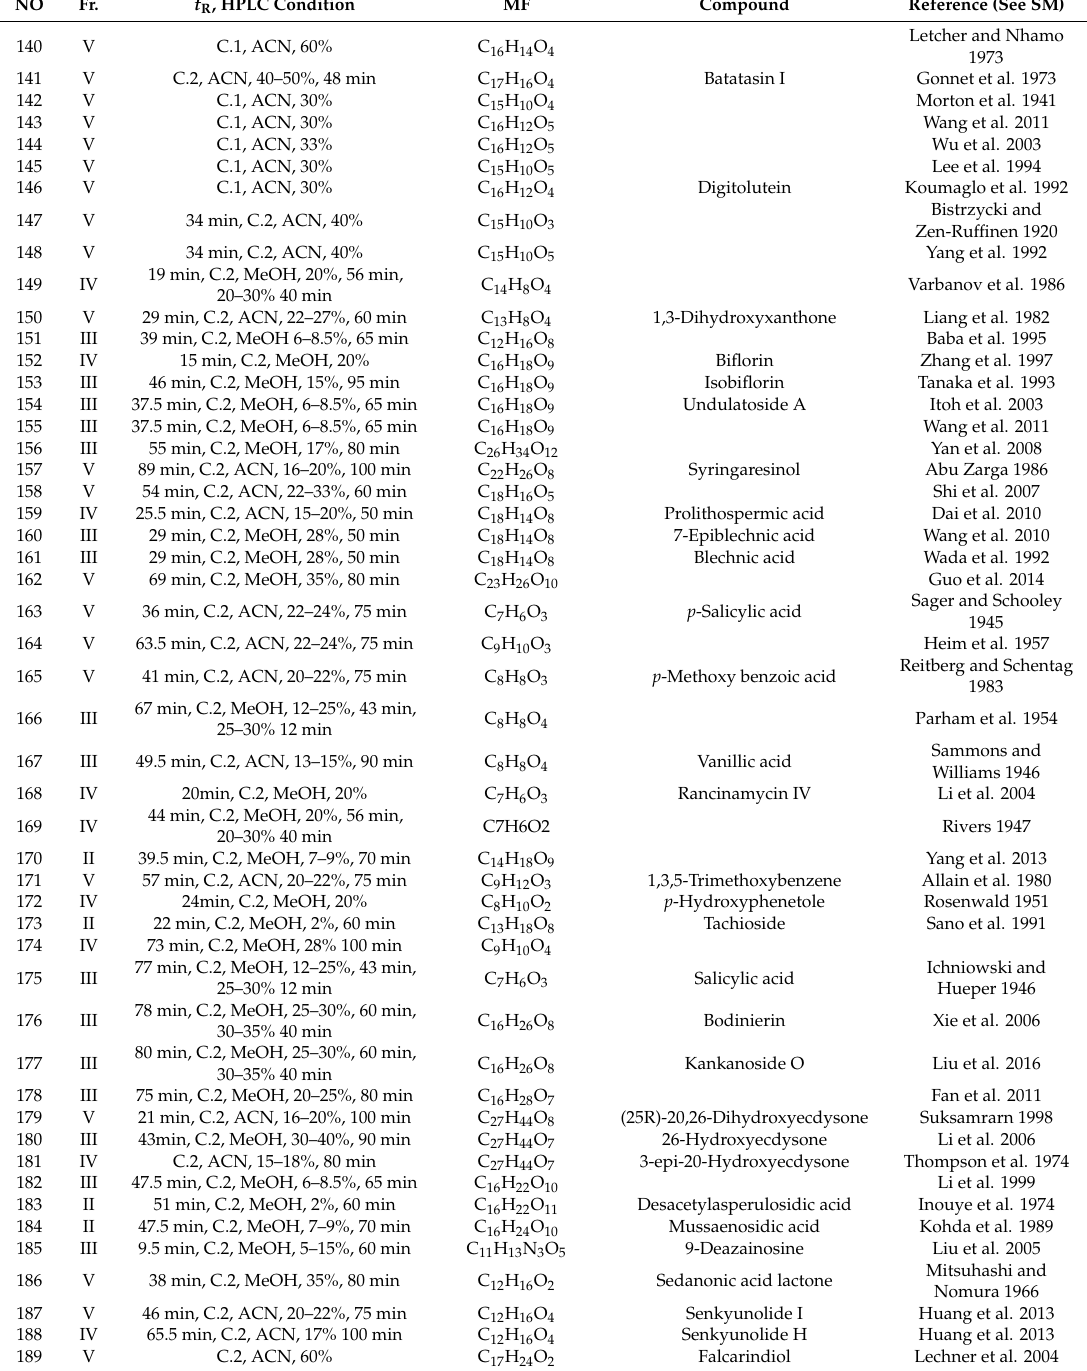
Table 3. Benzoquinone, naphthoquinone, anthraquinones, or phenanphrene derivatives (#140–149), xanthones, chromone, and γ -pyrone derivatives (#150–155), lignans (#156–162), other aromatic compounds (#163–175), and other types of compounds (#176–189) isolated from Jing